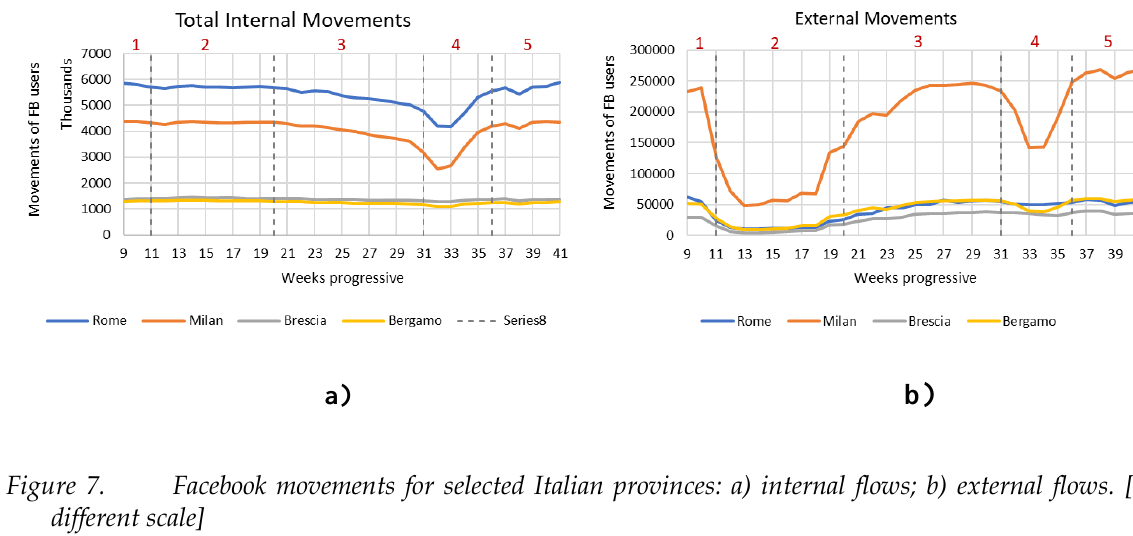
Figure 6. Facebook movements: a) total and internal to the provinces; b) interprovincial [Note: different scale].